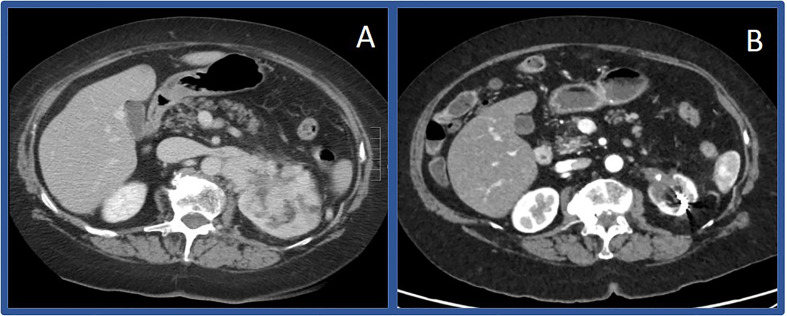
Computerized tomography scans before and after immunotherapy in Case #1 Initial CT scan showing large left sided renal mass in April of 2019 (A) compared to CT scan in March of 2020 (B) showing substantially decreased mass.